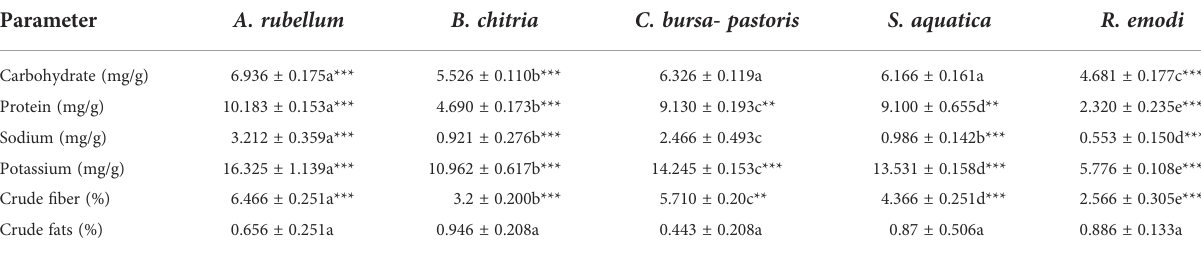
TABLE 2 Allium rubellum, Berberis chitria, Capsella bursa-pastoris, Stellaria aquatica, and Rheum emodi nutritional